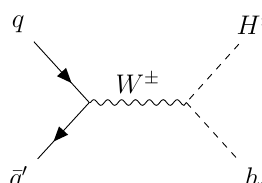
Figure 7. Dominant leading-order s -channel Feynman diagram for pp → H ± h production.